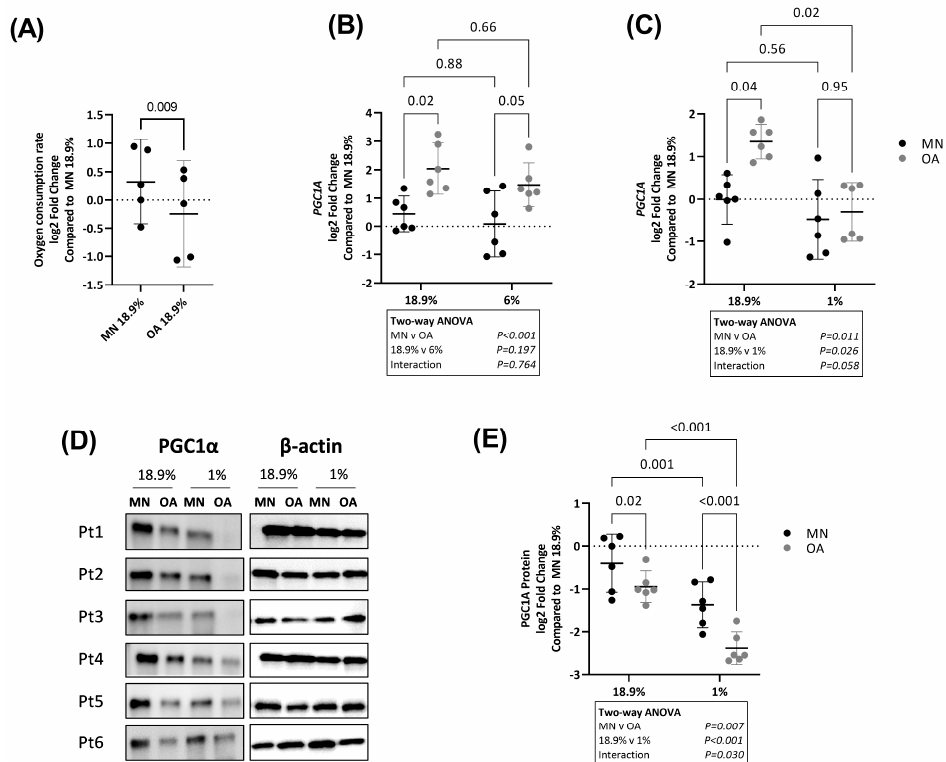
Figure 7. Comparison of oxygen consumption rate and PGC1 α expression in OA chondrocytes and chondrocytes from macroscopically normal cartilage maintained in 18.9% compared to 6% or 1% oxygen. Paired samples of human chondrocytes isolated from macroscopically normal (MN) and osteoarthritic (OA) cartilage regions within OA joints were plated in duplicate plates. One plate was transferred to a standard tissue culture incubator (18.9% oxygen) and the other transferred to a hypoxia incubator maintained at either 6% or 1% oxygen for 24 h. Chondrocytes from a different set of patients were used to compare the effects of 18.9% vs. 1% oxygen than those used to compare the effects of 18.9% vs. 6% oxygen. ( A ) Comparison of oxygen consumption rate in OA chondrocytes and chondrocytes from MN cartilage maintained in 18.9% oxygen. Comparison of RNA levels (measured by qPCR) of ( B ) PGC1 α in cells maintained in 18.9% vs. 6% oxygen and ( C ) PGC1 α in cells maintained in 18.9% vs. 1% oxygen. ( D ) Western blots showing PGC1 α protein levels and ( E ) quantification of PGC1 α protein expression using band densitometry in OA chondrocytes and chondrocytes from MN cartilage maintained in 18.9% vs. 1% oxygen. Pt = patient. Data shown are mean ± 95% CI. All data were analysed by two-way ANOVA. Statistically significant differences between groups following post hoc testing are shown on graphs. p < 0.05 was considered statistically